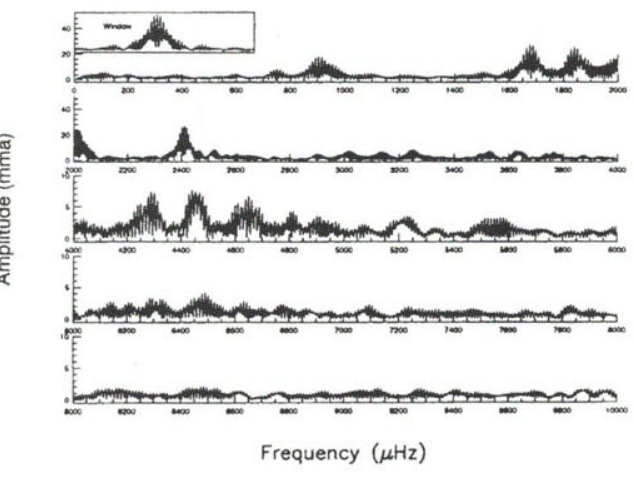
Fig. 17. The FT for the November 1990 data on HL Tau